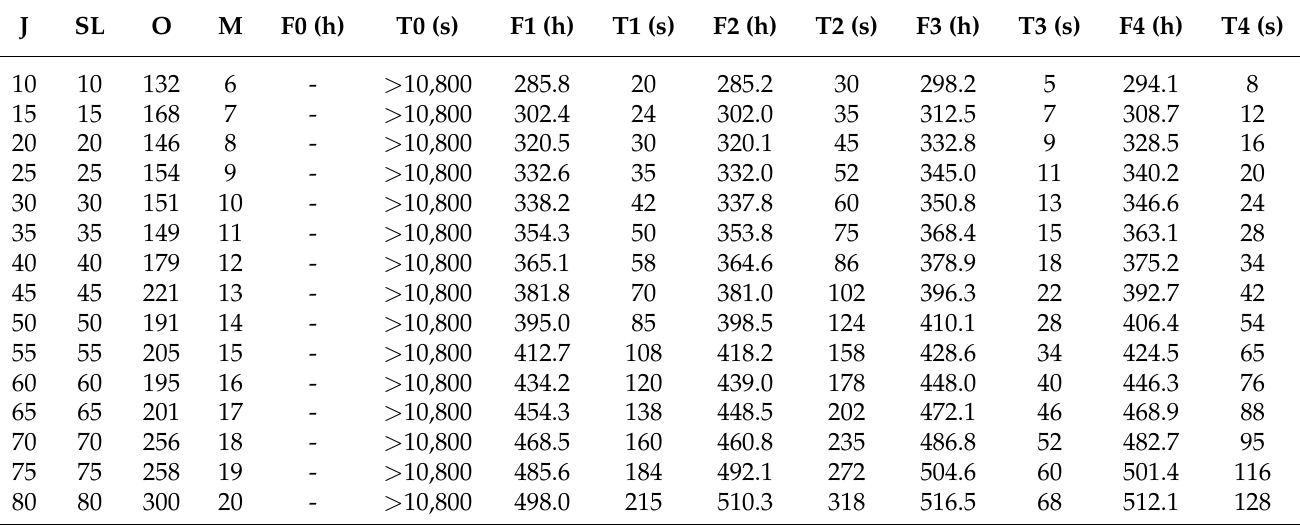
Table 8. Computational results of the developed resolution methods for large randomly generated instances.